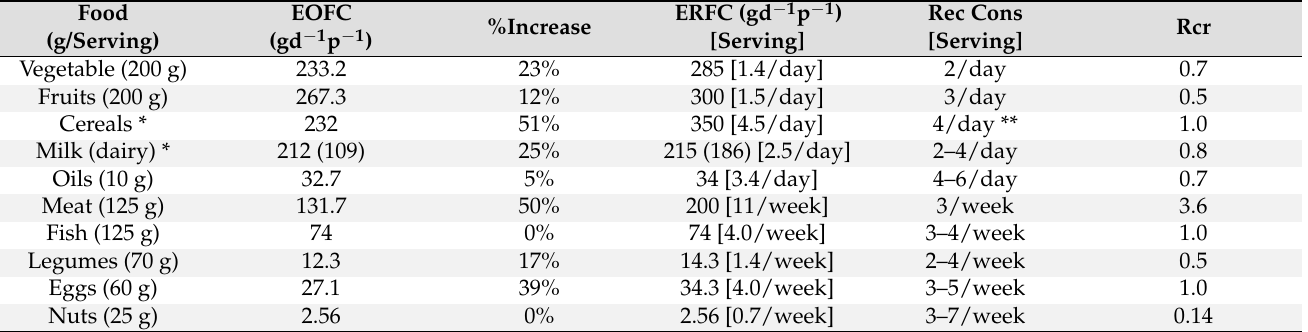
Table 1. Values obtained from the components of Equation (3) and ratio of consumed/recommended